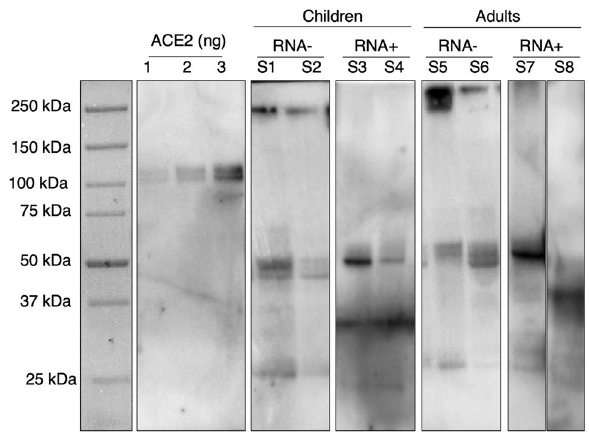
Figure 1. Western blot image showing sACE2 species in children and adults. First panel: molecular weight marker. Second panel: different amount of sACE2 used as standard. Rest of panels: representative distribution of sACE2 forms according to age group and infection status. RNA − non infected, RNA+ infected.